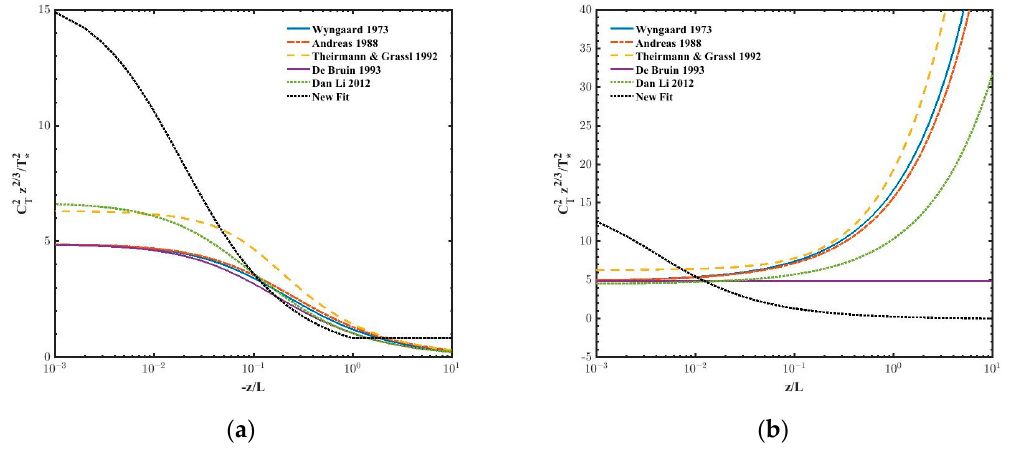
Figure 4. Comparison of several dimensionless temperature structure parameter functions: ( a ) unstable conditions ( 𝜉 < 0 ); ( b ) stable conditions ( 𝜉 > 0 ).